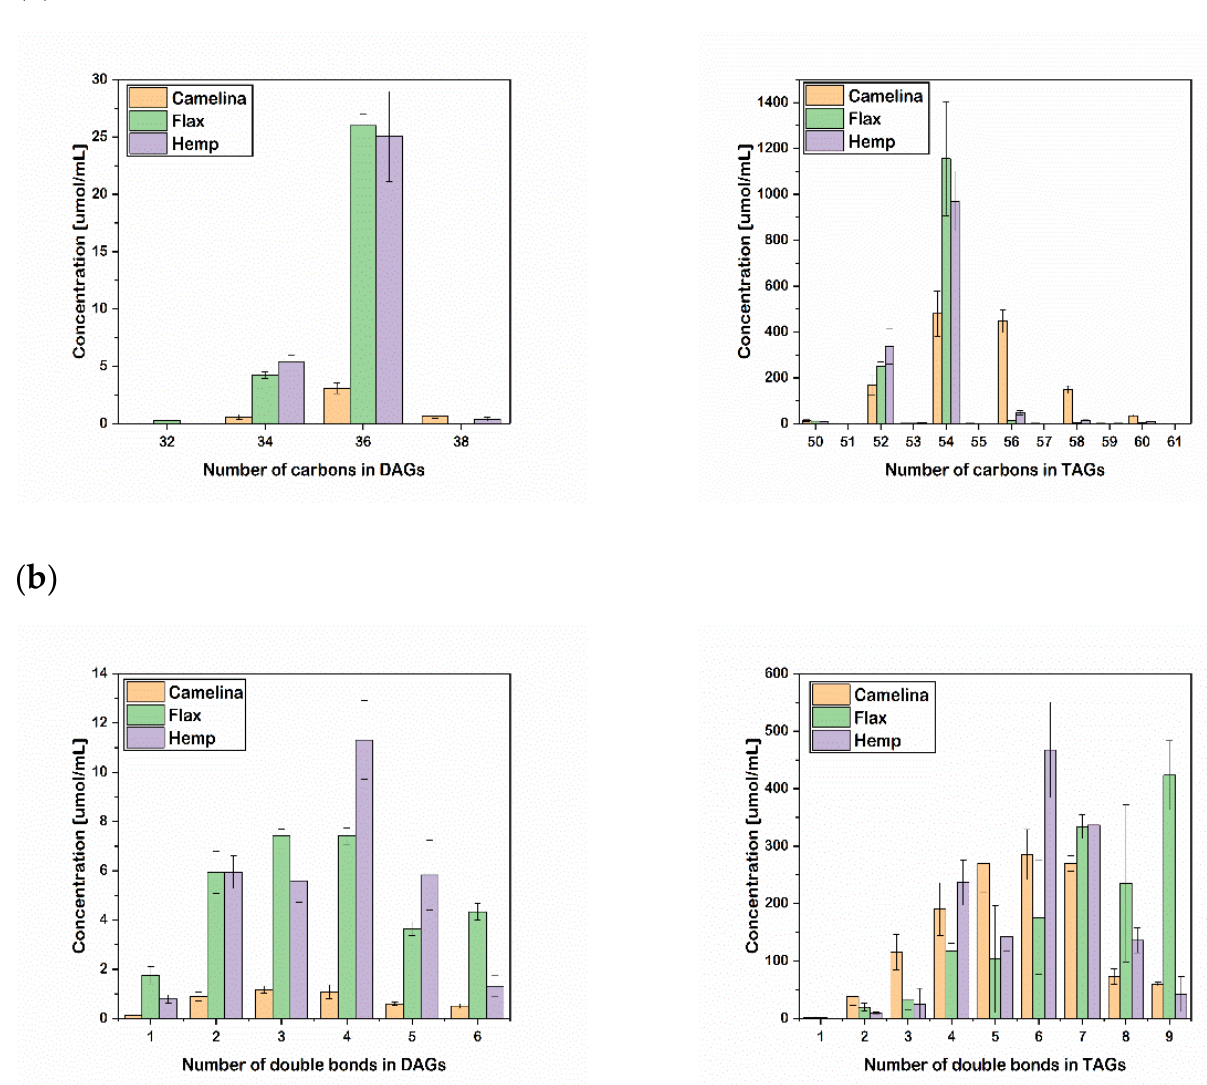
Figure 1. DAG and TAG composition based on the number of ( a ) double bonds and ( b ) carbon atoms. CA oil had a lower content of MUFAs and PUFAs in DAGs compared to FL and HP oils. The MUFA content of DAGs was estimated at 0.1 µ mol/mL, and the PUFA content (number of double bonds 2–6) in DAGs was similar for each group of double bonds and reached a maximum (1.2 µ mol/mL) for three double bonds in two fatty-acid chains. FL and HP oils were characterized by a much higher PUFA content in DAGs (number of double bonds 2–6), with the concentration being 3–7 times higher. HP oil had the highest DAG content with four double bonds (11.3 µ mol/mL), and FL oil had the highest DAG content (4.3 µ mol/mL), with six double bonds in the FAs (Figure 1). Content of MUFAs in TAGs was negligible compared to PUFAs in each of analyzed oil (CA, 2.2 µ mol/mL; FL, 1.8 µ mol/mL; HP, <0.1 µ mol/mL). CA oil had the highest TAG content with group of two, three and five double bonds in three fatty-acid chains. The concentration of PUFAs in FL oil increased with the number of double bonds, reaching a maximum for nine double bonds in the FAs (423.6 µ mol/mL), which is much higher compared to CA (60.3 µ mol/mL) and HP oils (42.5 µ mol/mL) (Figure 1a). DAGs with 34 and 36 carbons were present at higher concentrations in HP and FL oils than in CA oil, whereas CA oil had the highest content of DAGs containing 38 carbons (0.7 µ